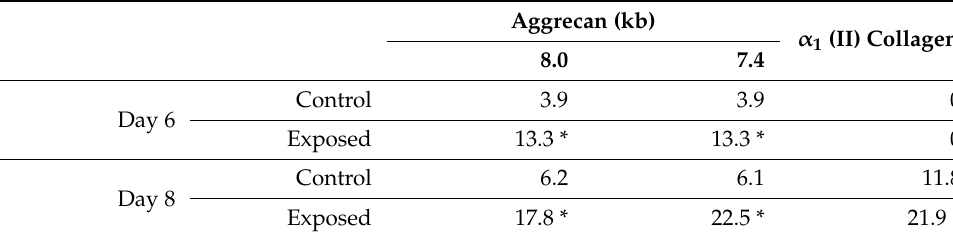
Table 1. Indices of chondrogenesis on day 8 with PEMFs. On day 8 of development, during maximal chondrogenesis, ossicles exposed to PEMFs demonstrated a two-fold increase in sulfate incorporation into proteoglycan and glycosaminoglycan content compared to unexposed ossicles. The spatial area of ossicle comprised of cartilage and the number of chondrocytes were increased by PEMF exposure. The glycosaminoglycan (GAG) contents expressed per unit area or per chondrocyte and the chondrocyte:matrix ratios were not different in control vs. exposed ossicles, indicating the production of more chondrocytes in PEMF-exposed ossicles rather than an increase in proteoglycan synthesis per chondrocyte. Adapted with permission from Ref. [10]. 2002, Journal of Orthopaedic Research . Control PEMF Percent Difference p -Value mRNA aggrecan 6.1 22.5 269 0.02 mRNA type II collagen 11.8 21.9 86 0.05 35 SO 4 incorporation 2166 ± 387 4448 ± 293 0.005 (cpm/mg) GAG content ( µ g/mg) 1.4 ± 0.2 Cartilage area (mm 2 ) Chondrocytes (n) Chondrocyte/cartilage 29.2 24.2 n.s.